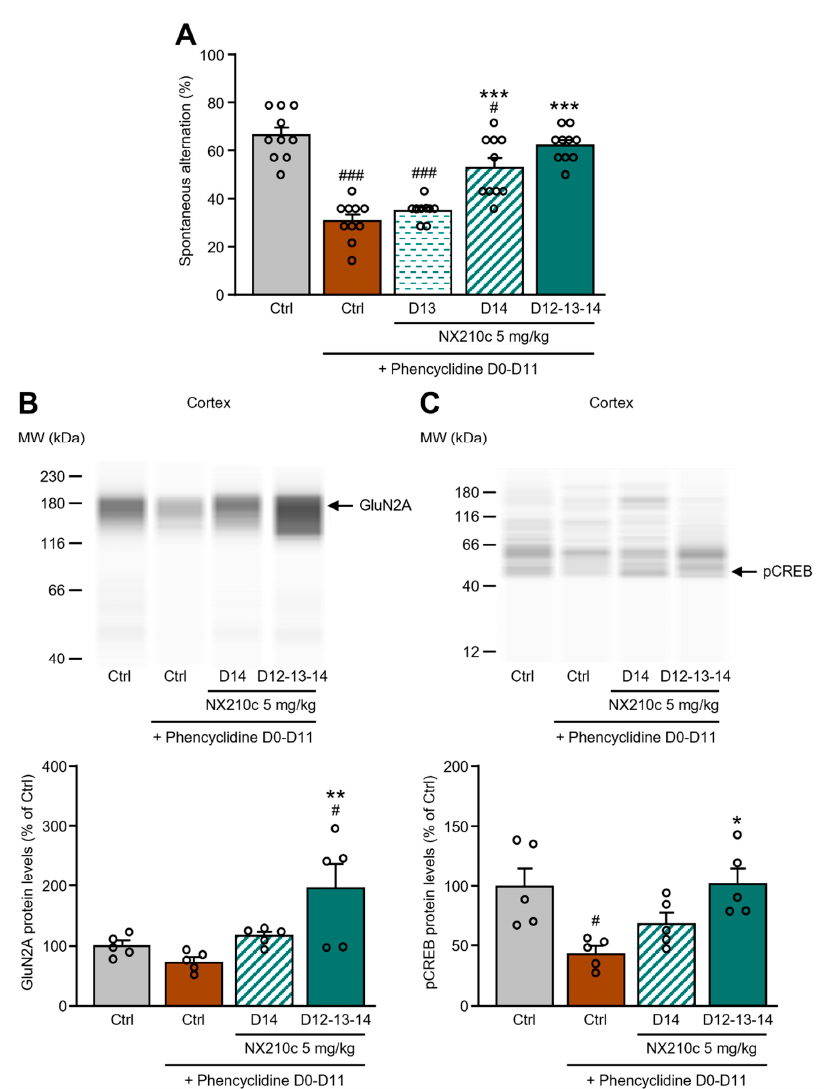
single injection of NX210c given acutely before cognitive assessment (i.e., 2 h) was not sufficient to induce molecular changes but nevertheless improved memory, perhaps by increasing transiently synaptic transmission.